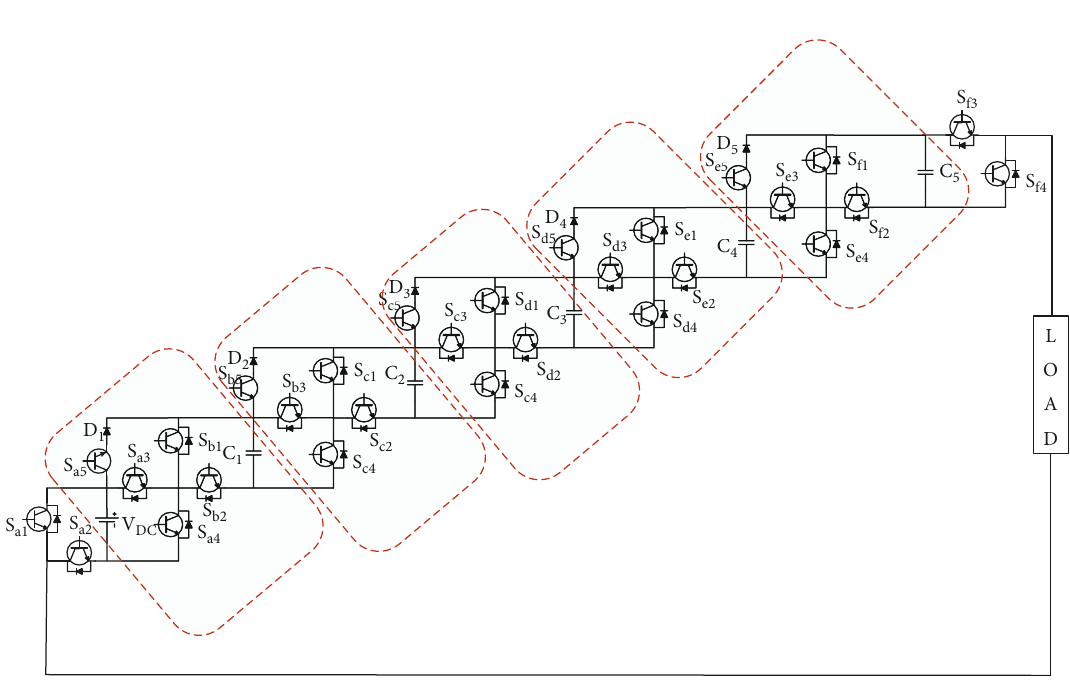
Figure 2: A high step-up SC multilevel inverter.